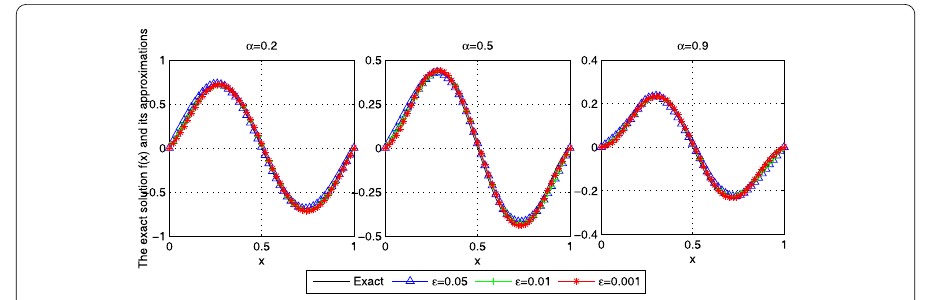
Figure 1 The comparison of numerical effects between the exact solution and its regularized solution for Example